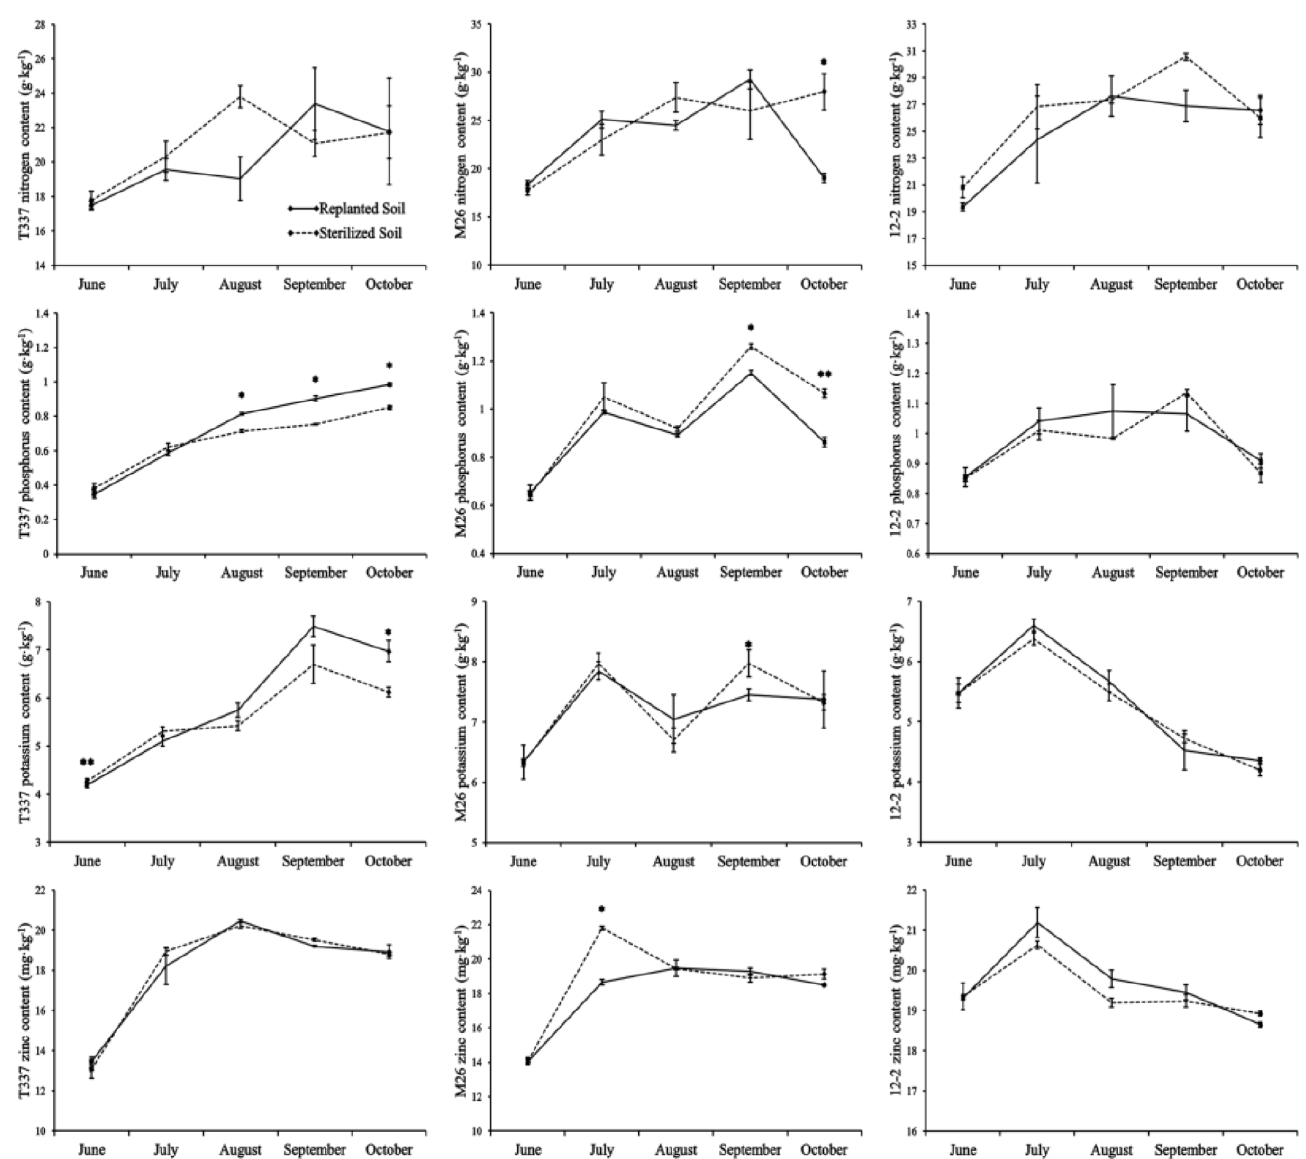
Figure 6. The mineral element content (nitrogen, phosphorus, potassium, and zinc) in the leaves of plants with different rootstock types planted in sterilized and replanted soil.